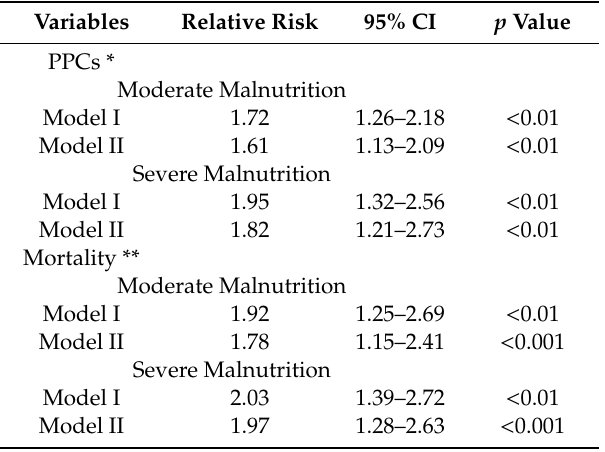
Table 3. Associations between malnutrition (yes vs. no) and postoperative pulmonary complications or death within 90 days after major abdominal surgery in patients with cancer ( n =